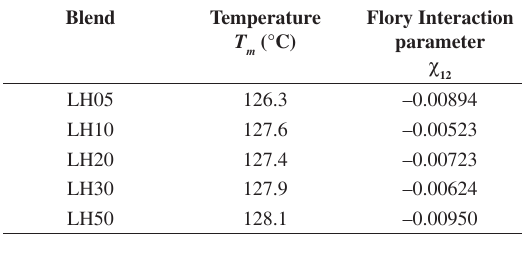
Table 4. Flory interaction parameter values for the blends .